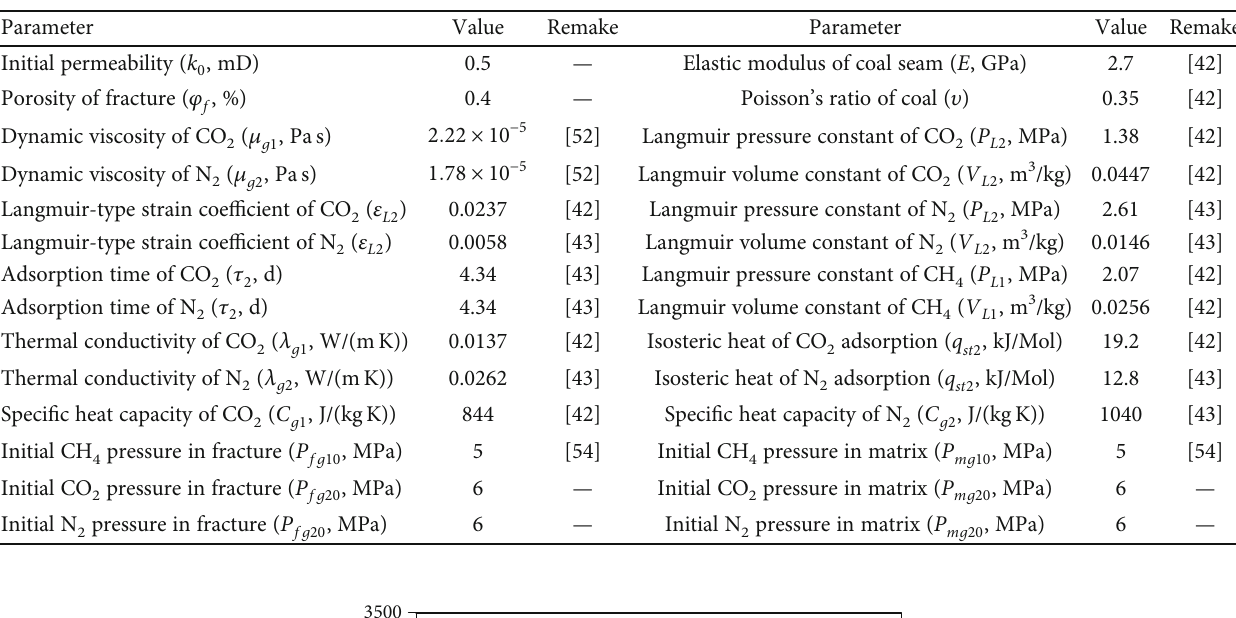
Table 3: Key parameters for ECBM recovery.